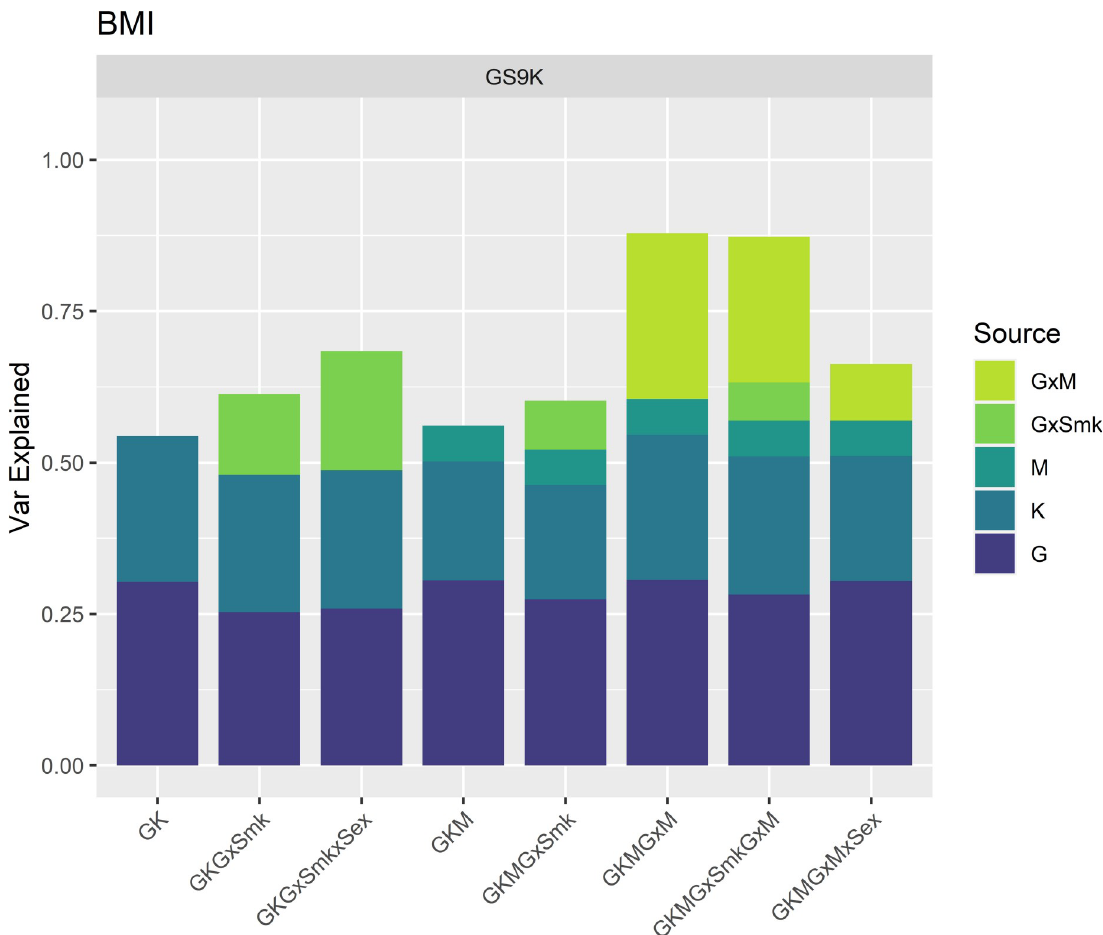
Fig 4. Proportion of BMI variation explained by genetic, environmental and methylation sources in GS9K. Proportion of BMI variance (y-axis) explained by each of the genetic, environmental and interaction sources in the corresponding models (x-axis). G: Genomic, K: Kinship, GxSmk: Genome-by-Smoking, M: Smoking associated methylation, GxM: Genome-by-Methylation, GxSmkxSex: Genome-by-Smoking-by-Sex, GxMxSex: Genome-by-Methylation-by-Sex.